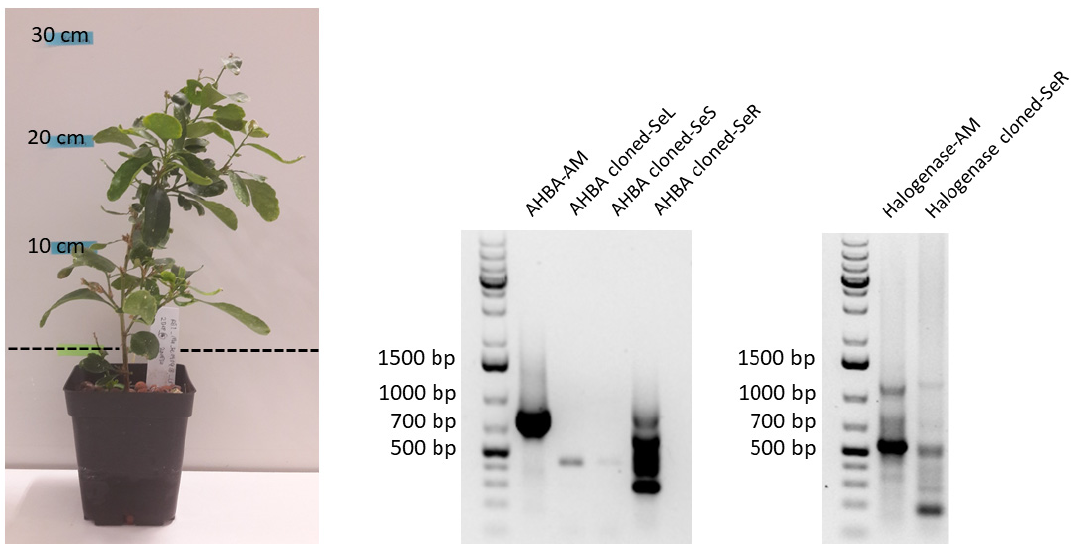
Figure 8. A six-month-old vegetatively cloned G. heterophylla plant from a stem of G. heterophylla collected in 2018, originating from South Africa ( left ). PCR products of the amplified AHBA syn- thase genes spanning around 755 bp in the different parts of the cloned G. heterophylla ( middle ). PCR products of the amplified halogenase genes spanning around 550 bp in the different parts of the cloned G. heterophylla ( right ). AM indicates A. mirum (DSM 43827) as the reference. Cloned-SeL, cloned-SeS, and cloned-SeR indicate leaves, stems, and roots of the vegetatively cloned G. hetero- phylla .